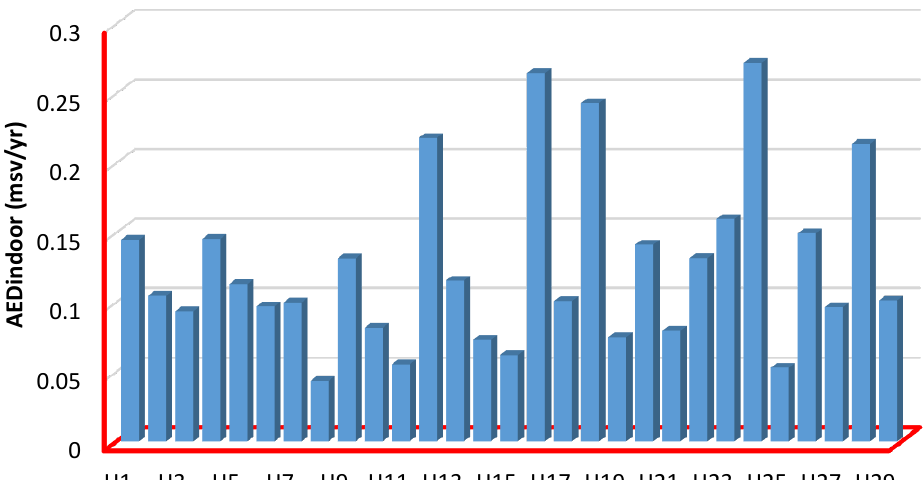
Figure 7. Indoor annual effective doses ( AED indoor ) for all herbs. Table 4 and Figure 8 represent the minimum, maximum, and mean annual effective doses (AACDE) values due to the intake of 238 U, 232 Th, and 40 K radionuclides through eat- ing the medical plants (herbs), which were equal to 0.002304 ± 0.000091, 0.50869 ± 0.00024, and 0.0373 ± 0.00040 mSv/yr, respectively. Lemon Balm (H8) and Worm Wood (H24) herbs have the lowest and highest AACDE among all herb samples. The AACDE values were lower than the global average (0.3 mSv/yr) for natural radionuclide ingestion reported in the UNSCEAR 2000 report [32]. Table 5 compares our AACDE to those assessed in Egypt [55], South India [46], Ghana [2], Iraq [47] and Thailand [56]. According to the com- parison, our result is smaller than that of Egypt [55], and the amount of AACDE is higher than that South India [46], Ghana [2], Iraq [47], Turkey [57] and Thailand [56]. These figures are all considerably lower than the global average dose [32]. As a result, the medicinal plant samples tested here are radiologically safe for adult consumption and pose no risk to human health. According to the findings, there are no radiological health concerns associated with the use of these